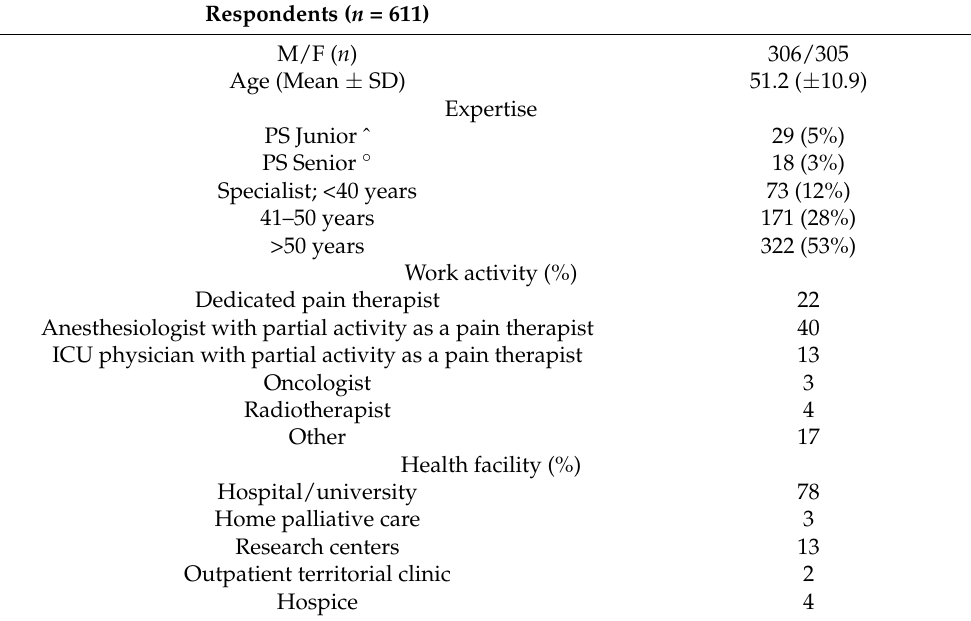
Table 2. Demographics and center